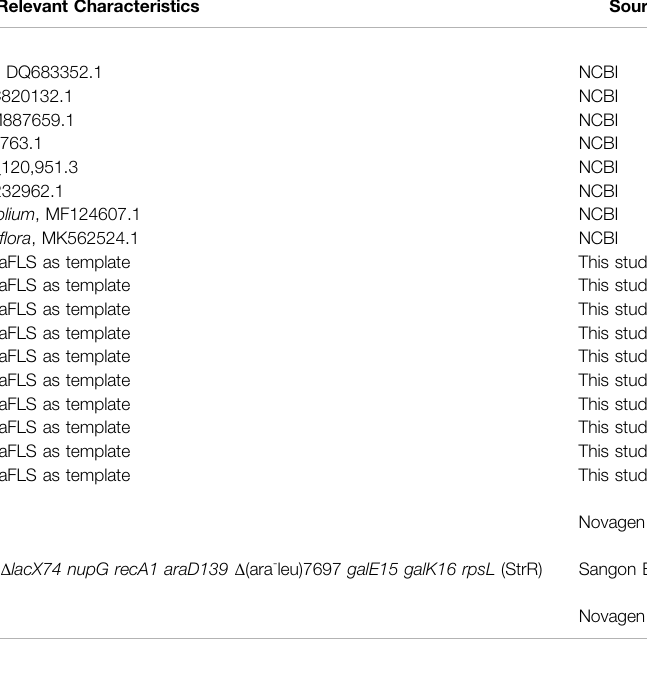
TABLE 1 | Genes, plasmids and bacterial strains used. Gene/Plasmid/Strains Relevant Characteristics Gene AnFNS Ⅰ